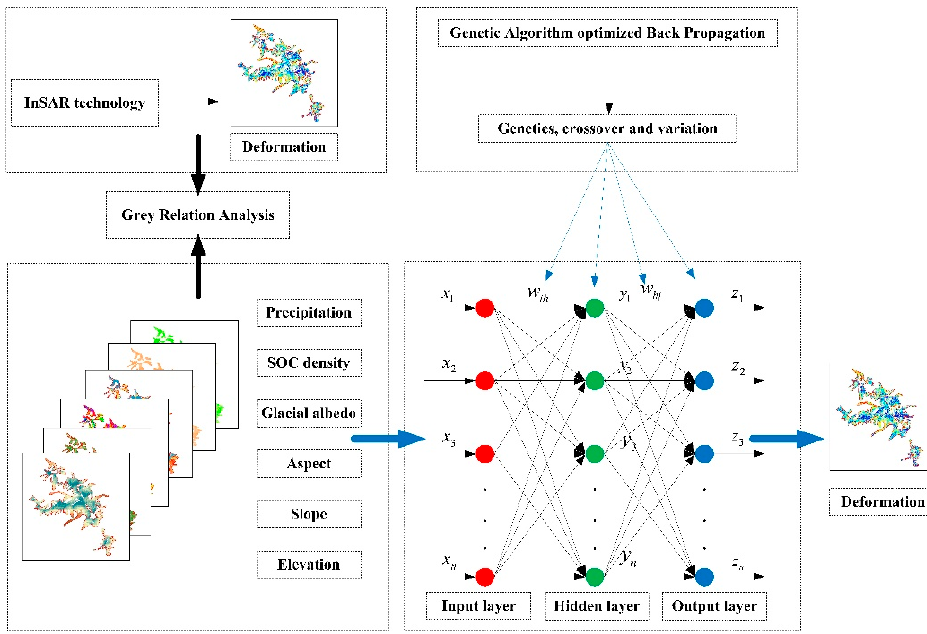
Figure 8. Flow chart of GA-BP neural